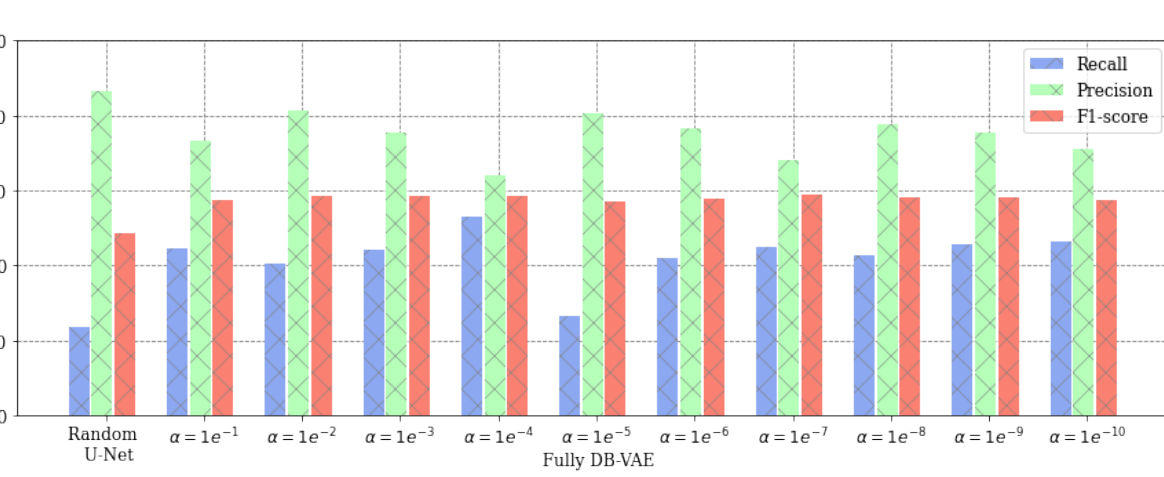
Figure 3. Classification metrics in [%], for the U-Net with random selection sampling and Fully DB-VAE with different values of α .